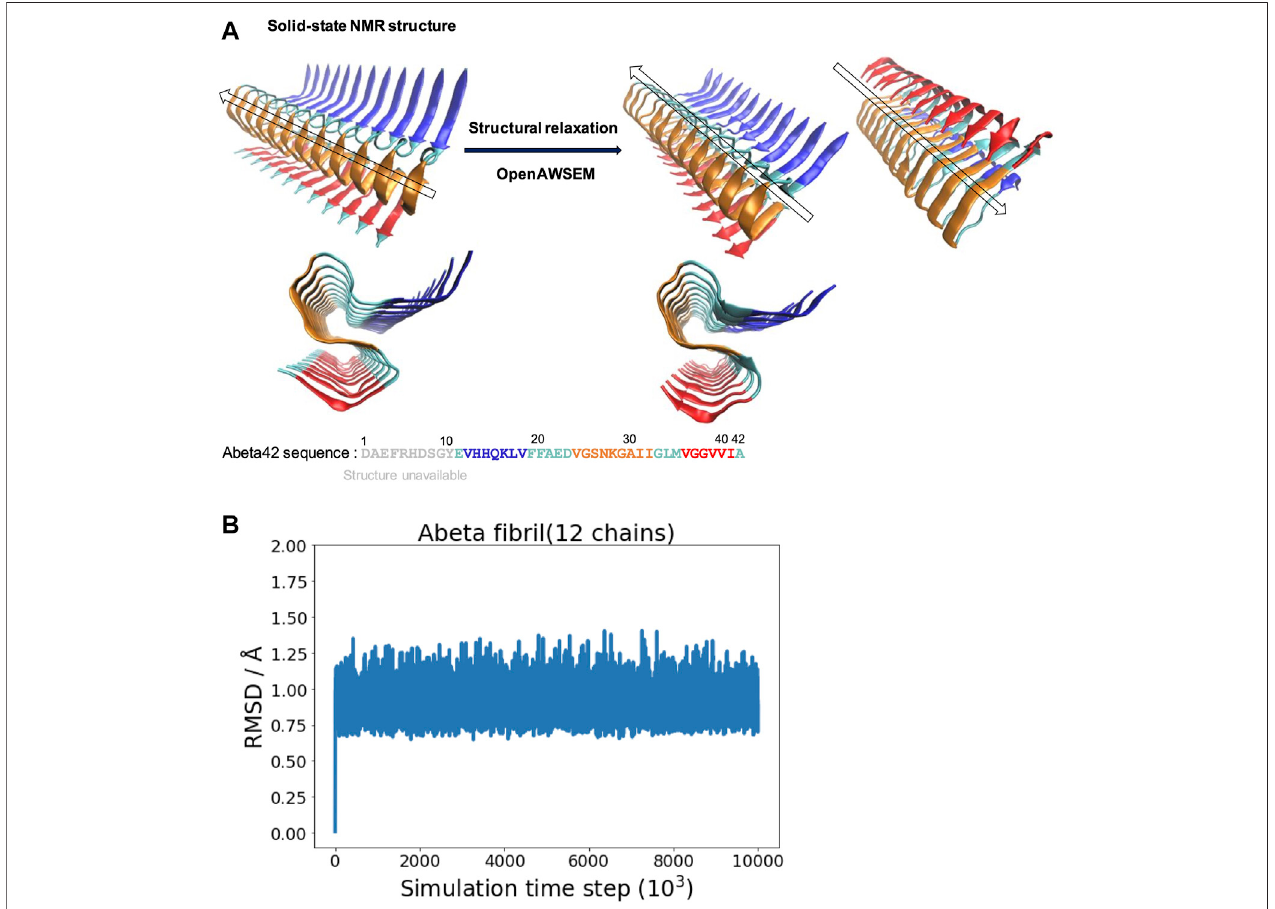
FIGURE1| Theoverallstructureoftheexperimentallydetermined fi brillarstructureandthesimulated fi brillarstructurearecompared. (A)Left: The fi brillarstructure of Abeta42 is determined by solid-state NMR [PDB ID: 2MXU (Xiao et al., 2015)]. The actual sequence length of the individual peptides in the structure is 32 (spanning from 11 to 42). The “ S ” shaped triple parallel-beta-sheet architecture can be seen from the side view below. Right: The simulated fi brillar structure. The experimental structure is structurally relaxed via molecular dynamics simulation using openAWSEM. Two different orientations of the relaxed structure are shown, with an arrow showingthedirectionofthe fi brilaxis.The “ S ” shapedtripleparallel-beta-sheetremainsinthesimulation.Differentcolorsrepresentdifferentlocalstructuralfeaturesofthe Abeta42peptide, de fi nedintheoriginalPDB fi le,illustrated usingthesequencebelow.Bluestrand(V12-V18),Cyanloops(E11,F19-D23,G33-M35,A42),Orangestrand (V24-I32)andRedstrand (V36-I41). (B) TheRMSD iscalculatedasafunctionofsimulation timestep(onlyoneofthethreeindependentsimulationtrajectoriesisshown).